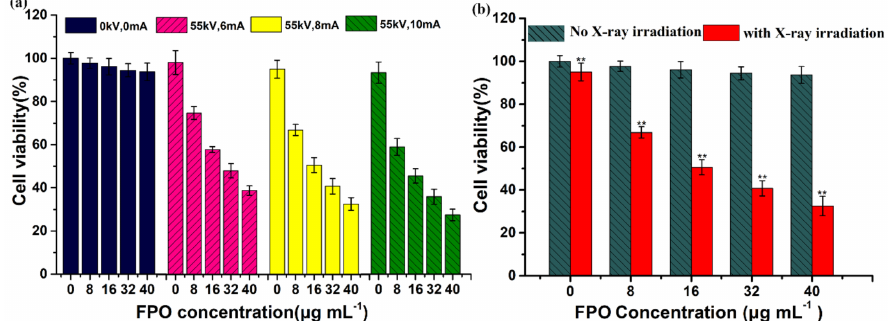
Figure 11. ( a ) Viability of 4T1 cell co-incubated with FPO@HMSNs-PAA (0–40 µ g · mL − 1 of FPO) after different RT treatment; ( b ) Cell viability comparison of FPO@HMSNs-PAA with (** p < 0.01) or without ( p > 0.05) RT treatment (55 kV, 8 mA). Data were represented as means ± SDs ( n = 6).